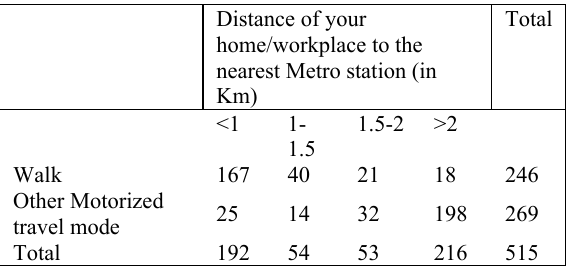
Table 3 . Frequency distribution of Trip Distances for different travel modes to access the metro